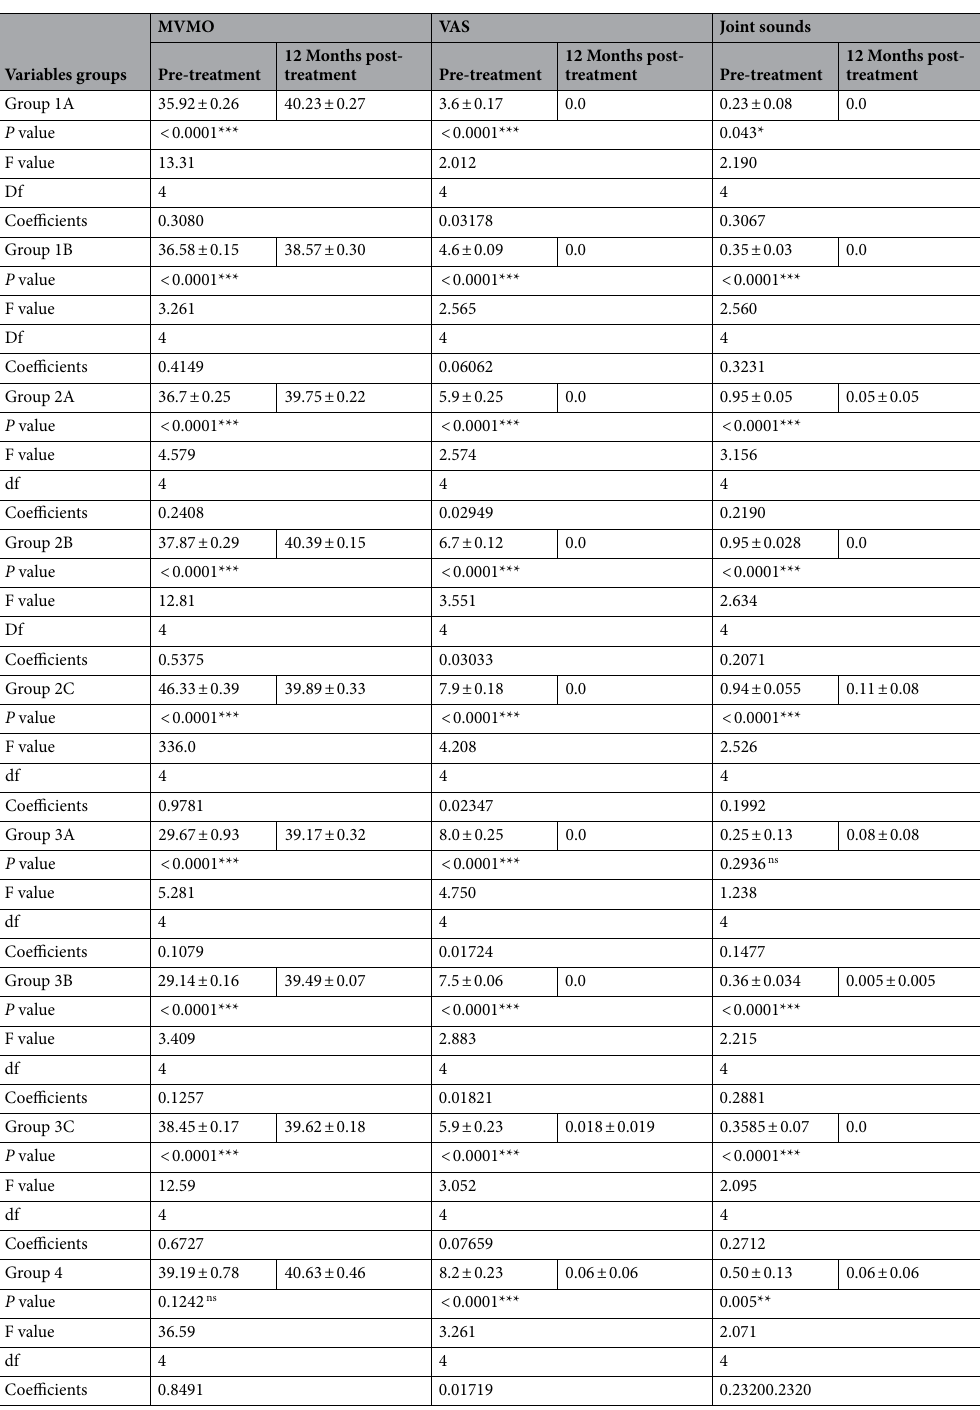
Table 4. clinical characteristics of the different pre-treatment and post-treatment changes of the clinical outcome variable in all the study groups. MVMO: Maximum voluntary mouth opening, VAS: Visual analogue scale. P value > 0.05 non-significant. P value < 0.05 significant. df: Degree of